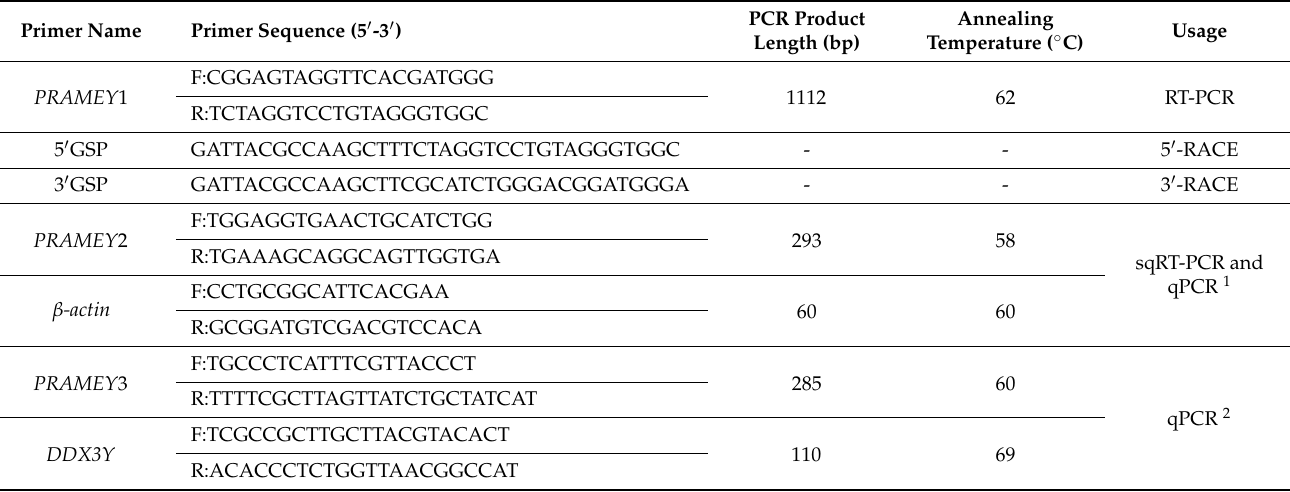
Table 2. The information on primers used in the present